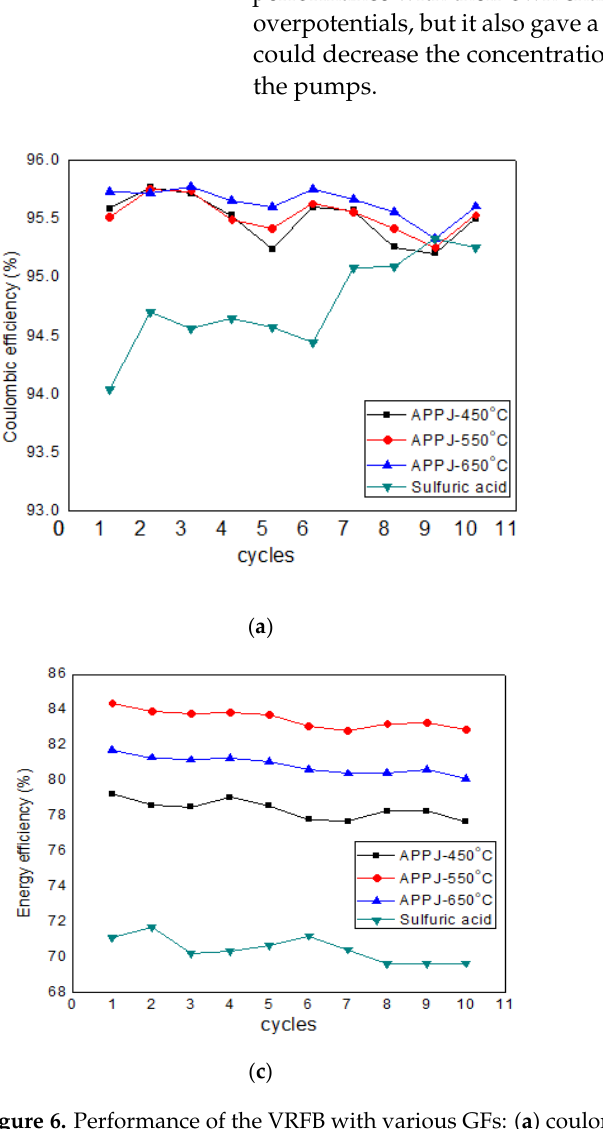
Figure 6. Performance of the VRFB with various GFs: ( a ) coulombic efficiency; ( b ) voltage efficiency; ( c ) energy efficiency; ( d ) discharge capacity.